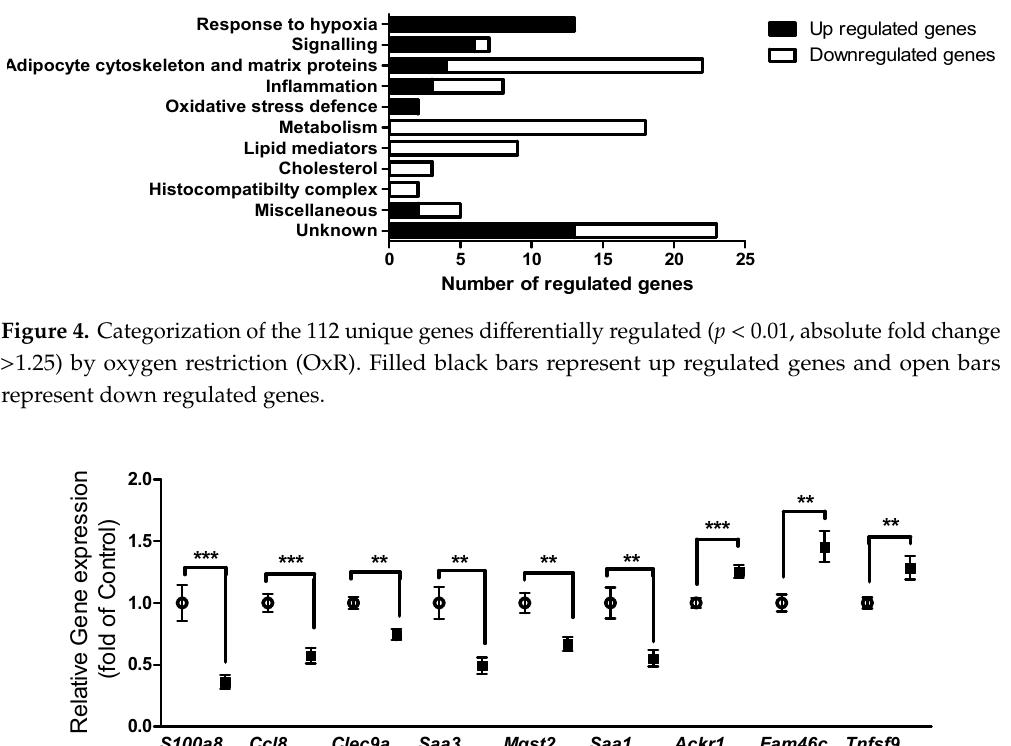
Figure 5. Oxygen restriction (OxR) mostly downregulated white adipose tissue (WAT) inflammatory-related transcripts. Open circles: control, filled squares OxR mice. Data are shown as mean ± SEM (n = 10). ** p < 0.01, *** p < 0.001.